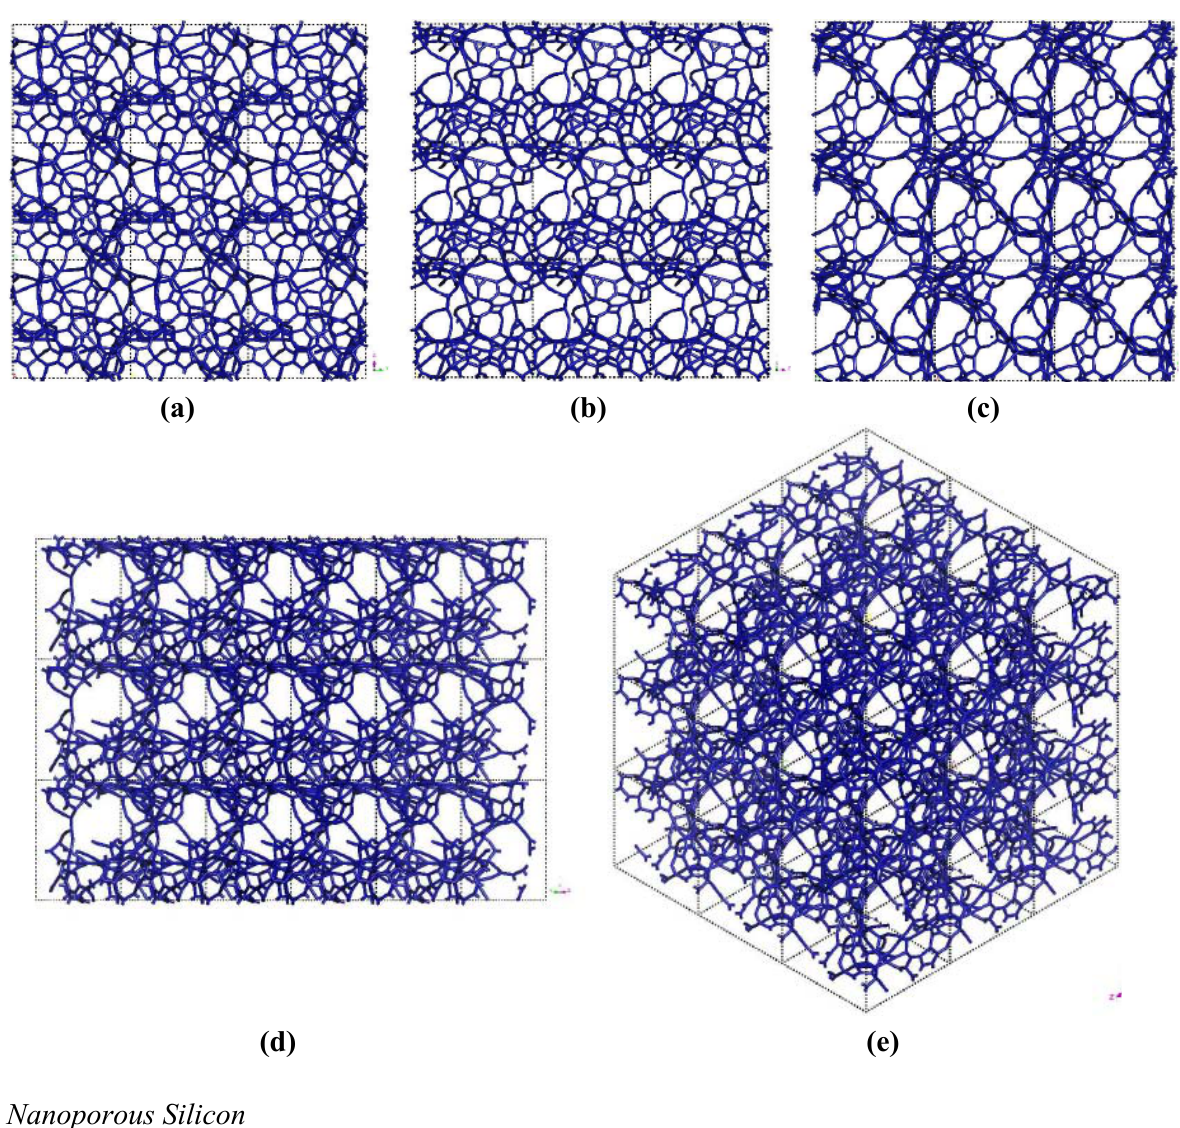
Figure 7. Pore structure obtained for 3 × 3 × 3 low density carbon cells. Prominent through pores exist along (c) z, (d) yz and (e) xyz, and smaller ones along (a) x and (b) y